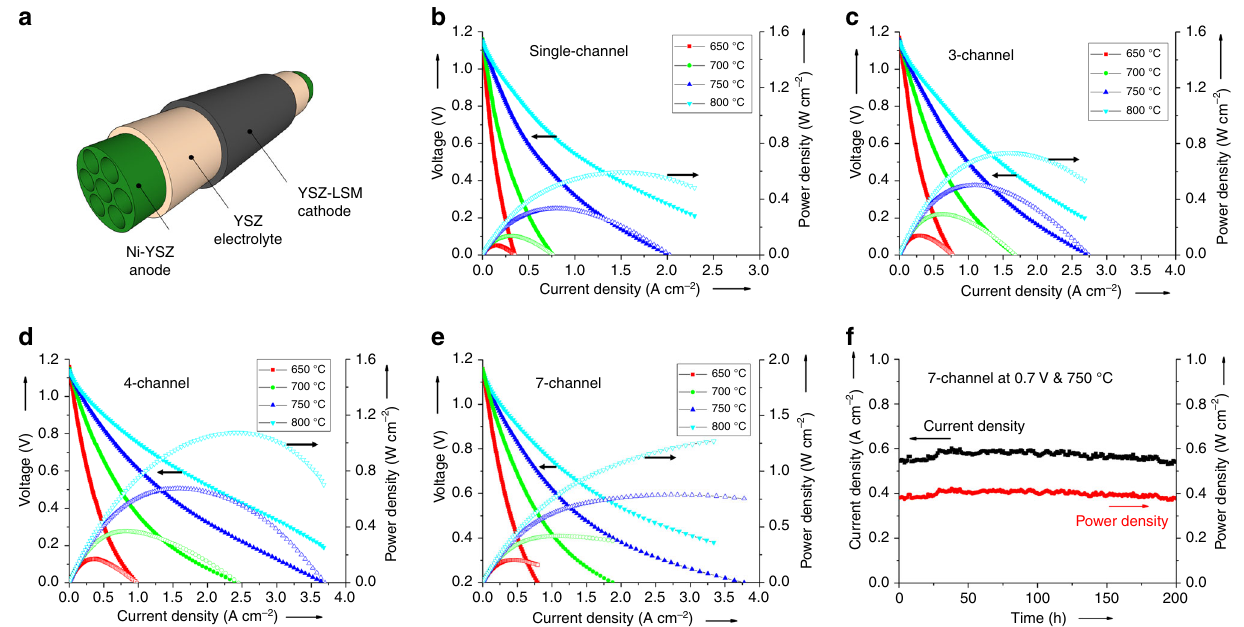
Fig. 7 Electrochemical properties of micro-monolithic solid oxide fuel cells. a Schematic diagram of a 7-channel micro-monolithic SOFC; b – e Effect of current density ( j ) on cell potential difference ( U ) and power density in the temperature range 650 – 800 °C, with 30 mL min − 1 H 2 as the fuel and ambient air as oxidant; f terminal current density and power density at a voltage of 0.7 V at 750 °C for 7-channel cell under H 2 /ambient air for 200 h